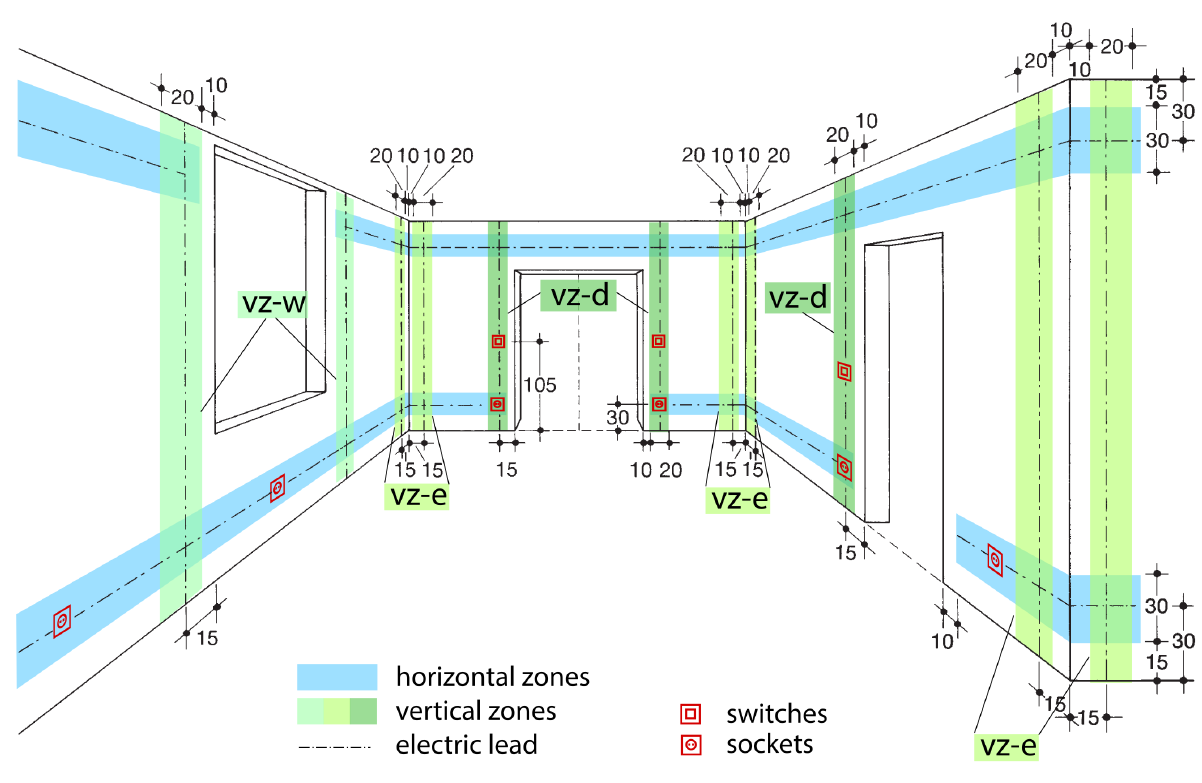
Figure 9: Recommended zones for electric lines according to the standard DIN 18015-3 in Germany. Horizontal zones (HZ) are highlighted in blue and vertical zones (VZ) in green colour. Electric leads are depicted as dotted lines. Preferred locations of power sockets and light switches are graphically